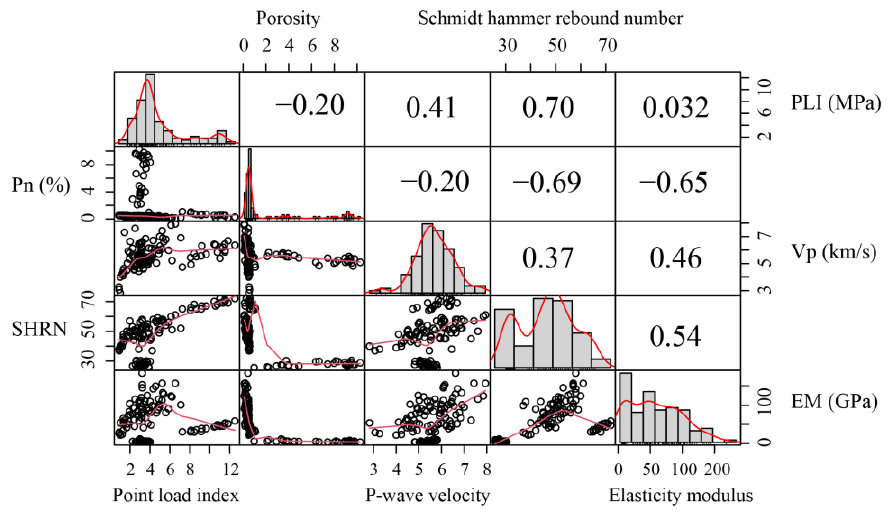
Figure 1. Correlation analysis results of four input variables and EM.